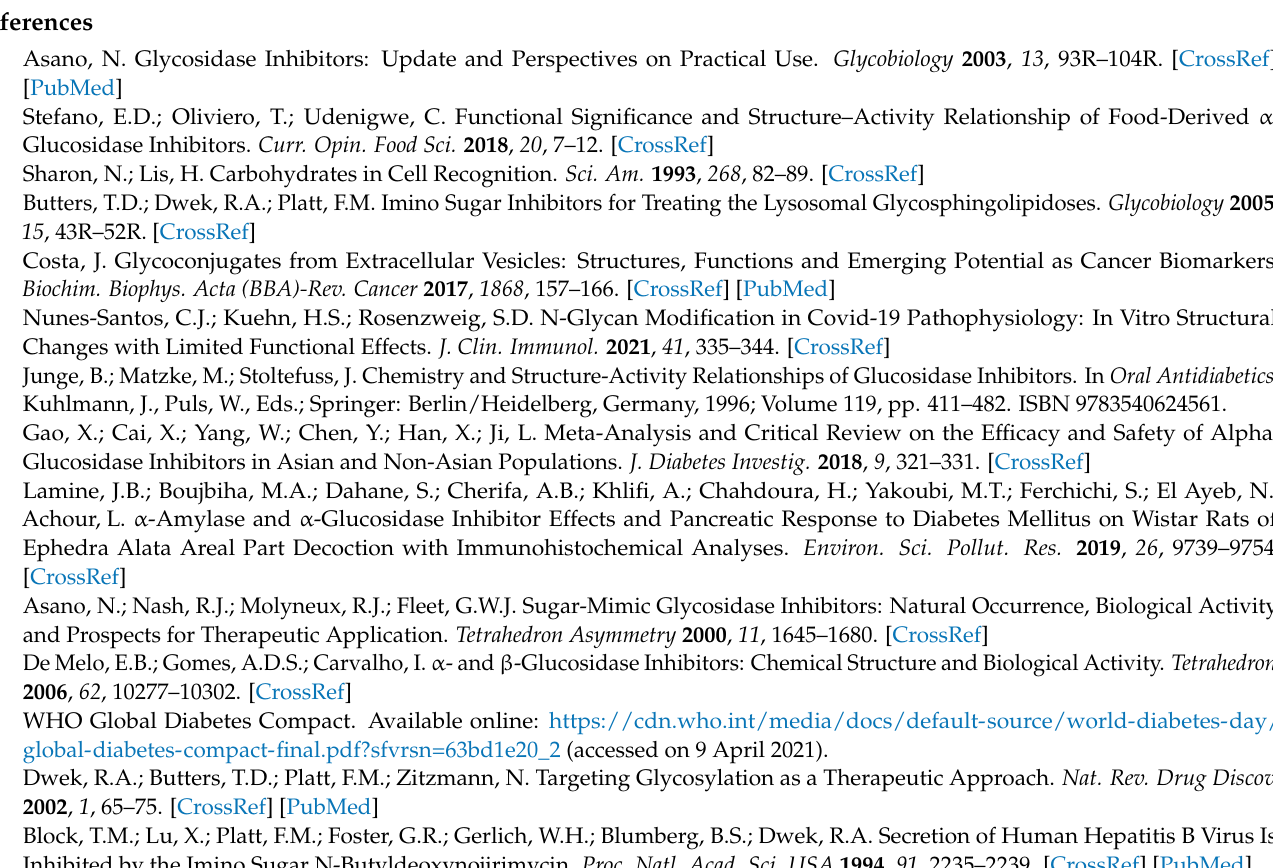
Table S2: Proteins differently expressed present in at least two replicates of Synechococcus sp. GFB01.; Figure S1: Inhibitory activity of microalgae and cyanobacteria extracts. (A) Samples with longer inhibi- tion for β -glucosidase on agar plate screening. Plates with microorganisms that inhibited the enzyme- substrate reaction for 60 min. (B) Samples with best result according to biological